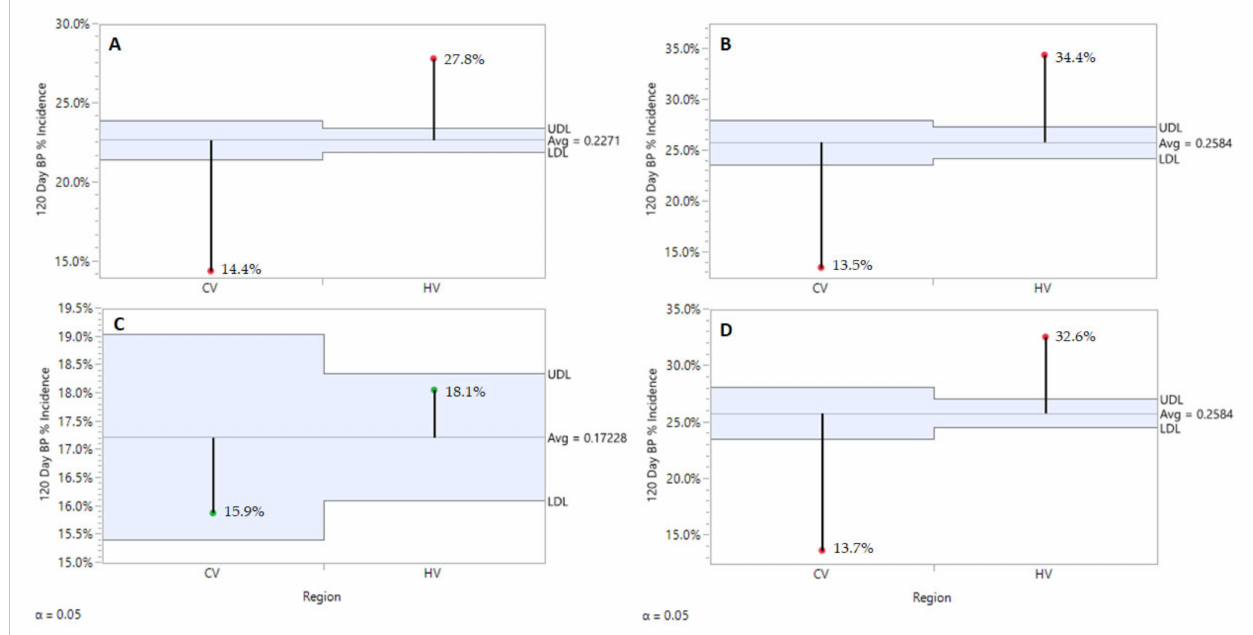
Figure 2. Region effect on ‘Honeycrisp’ bitter pit incidence after 120 days of refrigerated storage with all rootstocks and years combined ( A ), in 2016 with all rootstocks combined ( B ), in 2017 with all rootstocks combined ( C ), and in 2018 with all rootstocks combined. JMP Fit XY Platform, Analysis of Means of Proportions of the binomial dataset, alpha =